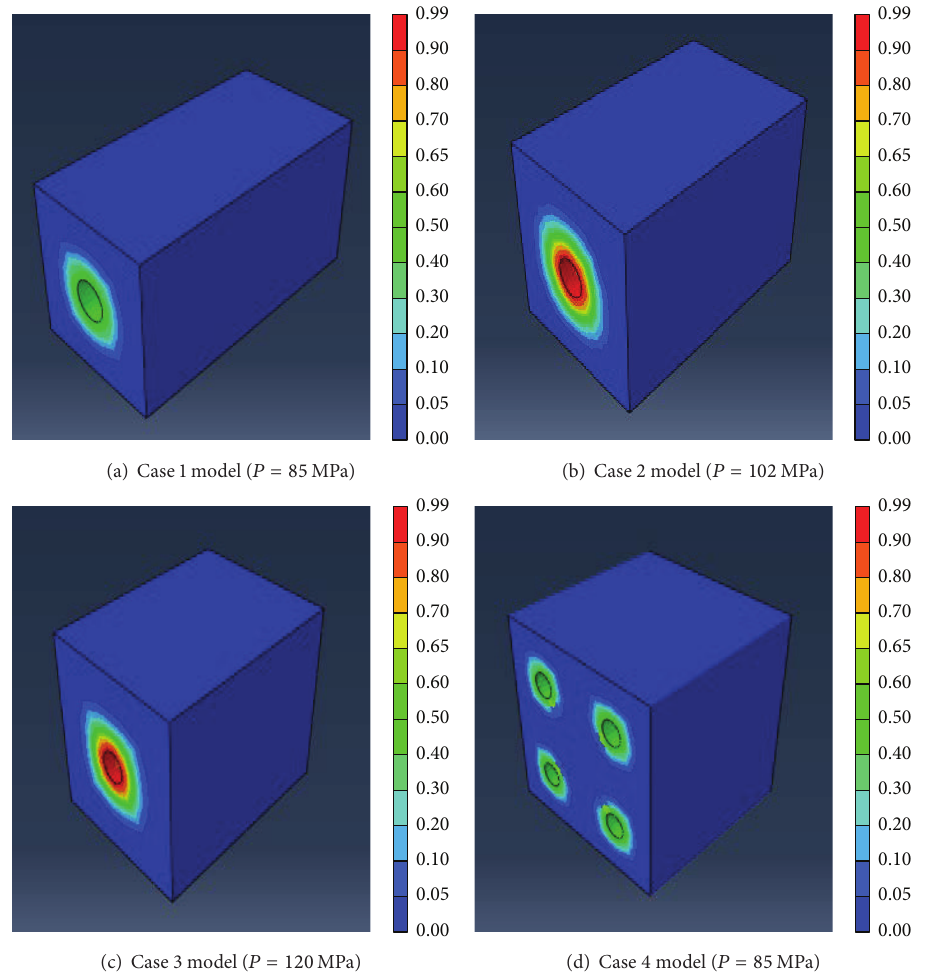
Figure 13: Probability of crushing occurrence determined based on excessive compression